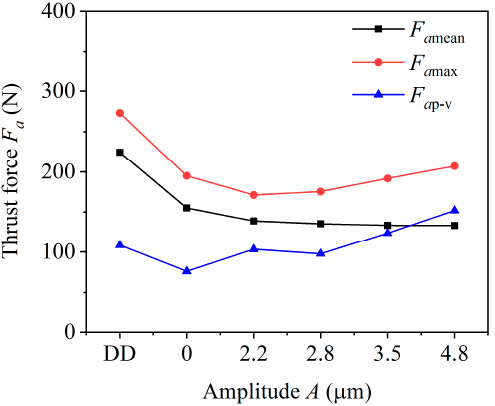
Figure 9. Thrust force comparison of UVPD and DD at various amplitudes. ( n = 1200 r/min, v f = 36 mm/min, f = 20 KHz, Q = 1 mm).